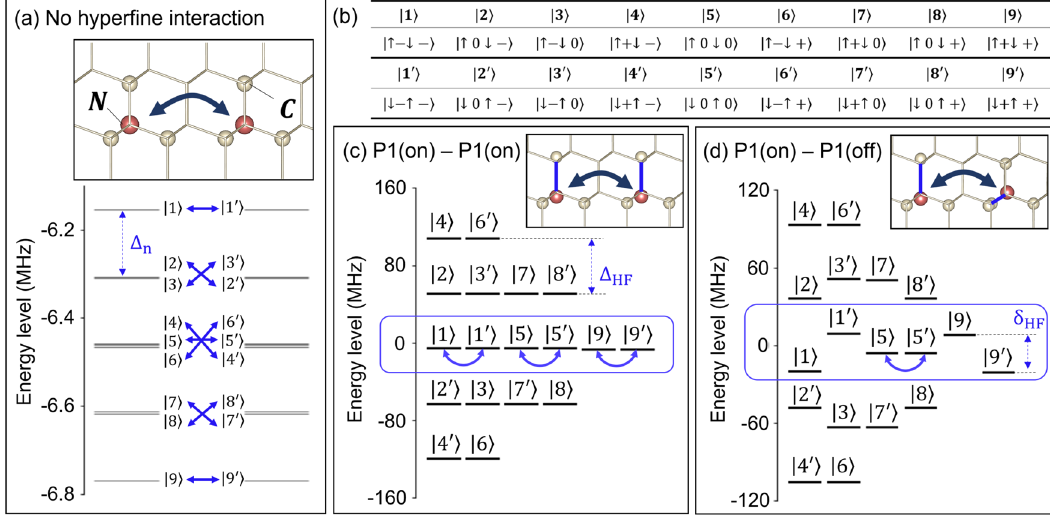
Fig. 5 Energy levels of a P1-P1 pair. a Energy level diagram of two P1 centers in which the on-site hyper fi ne interaction is ignored. The upper panel represents two P1 centers interacting with each other. The energy level diagram only shows states derived from " 1 # 2 ij and # 1 " 2 ij , where = + 1/2 and − 1/2 states of the P1 electron spin, respectively. Considering the nuclear-spin states ( þij for m "ij and #ij are the m s m I = 0, and (cid:1)ij for m I = − 1), there are 18 states, which are labeled as 1 ij ; ¼ ; 9 ij for the " 1 # 2 ij -derived states, and 1 0 ij ; ¼ ; 9 0 ij for the " ij -derived states as speci fi ed in ( b ). In the absence of the hyper fi ne interaction ( a ), the spin states are split by nuclear Zeeman splitting ( Δ # 1 2 and 9 electron spin fl ip- fl op transition channels are allowed (indicated by blue arrows). c Energy levels of a P1 pair having the same JT axes parallel to the [111] direction. The energy levels are largely shifted by the hyper fi ne interaction on the order of tens of MHz ( Δ HF ). The electron spin fl ip- fl op transitions are allowed only between 1 i $j j 1 0 i ; 5 i $j j 5 0 i and 9 ij $ 9 0 ij due to the energy level shifts. d Similar energy